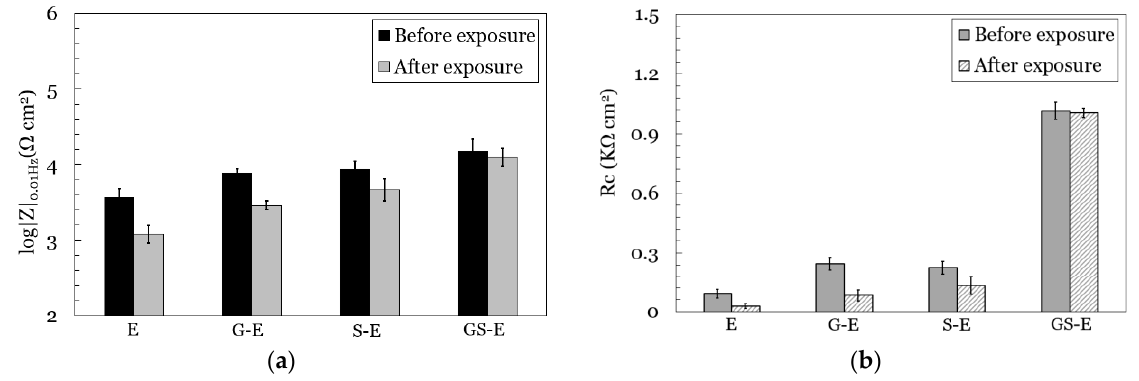
Figure 11. ( a ) Impedance value at 0.01 Hz and ( b ) coating resistance of coated rebars.